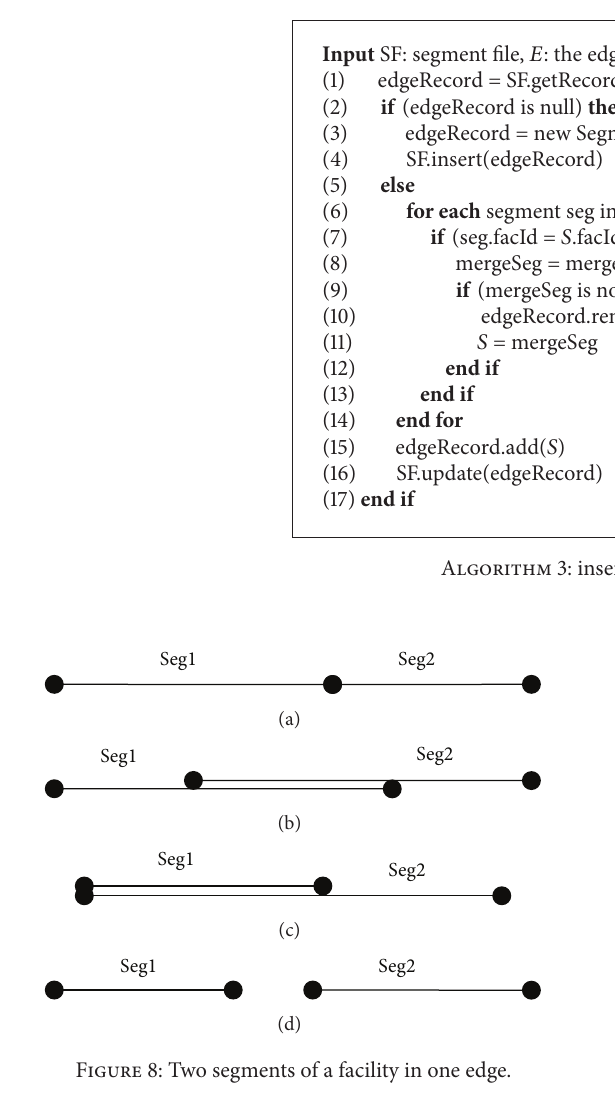
Figure 9: Records in